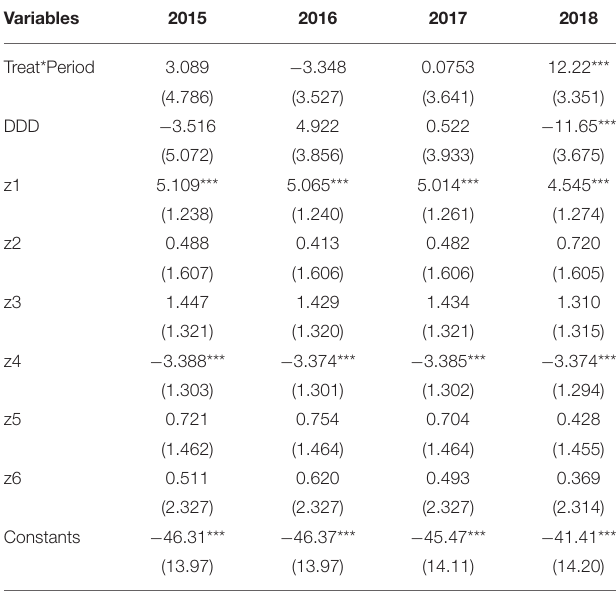
TABLE 6 | Dynamic effect of green innovation of enterprises in